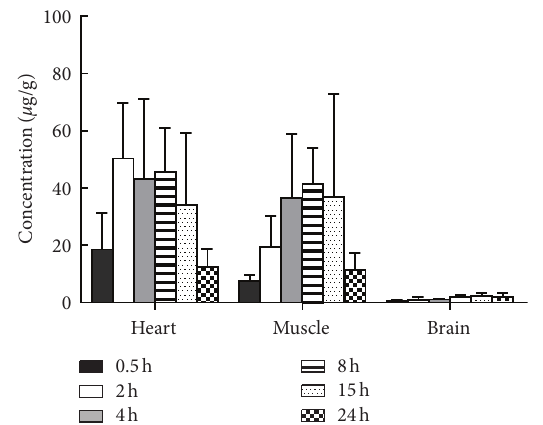
Figure 6: Concentrations of crizotinib in the heart, muscle, and brain at 0.5h, 2h, 4h, 8h, 15h, and 24h after an intragastric administration of crizotinib (500 mg/kg) in healthy mice. Data are means ± SD.